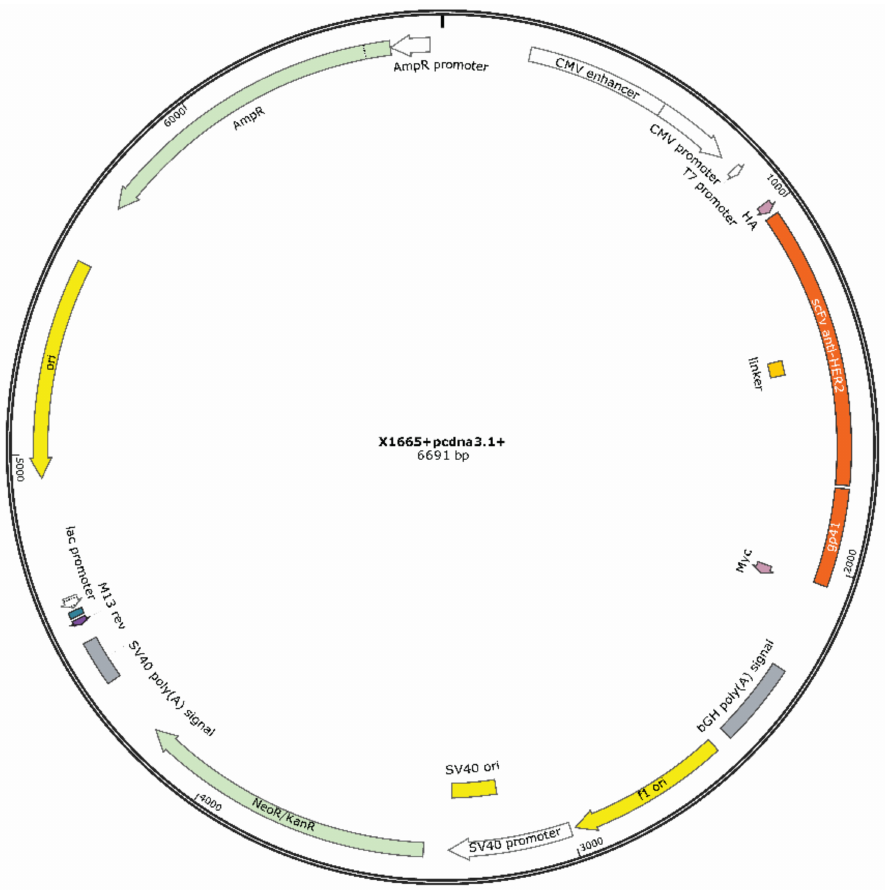
Figure 2. Constructed DNA plasmid encoding the scFv-HER2_gp41 sequence.